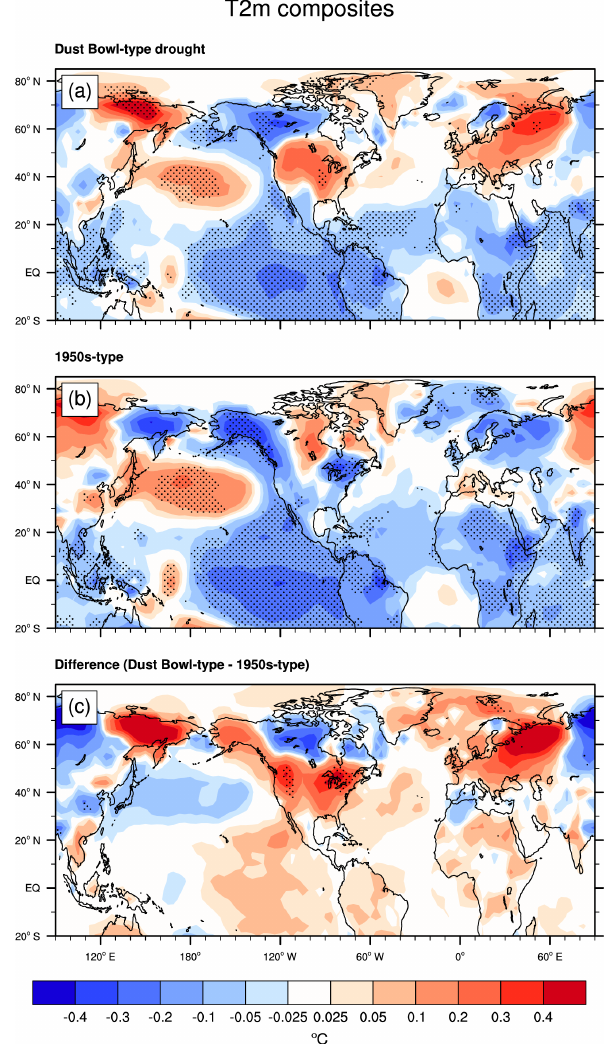
Figure 4. Composites of 2m temperature from EKF400 for Dust Bowl-type droughts (a) , 1950s-type droughts (b) , and their differ- ence (c) . Stippling indicates significance ( p < 0 . 05) based on a non- parametric Wilcoxon–Mann–Whitney